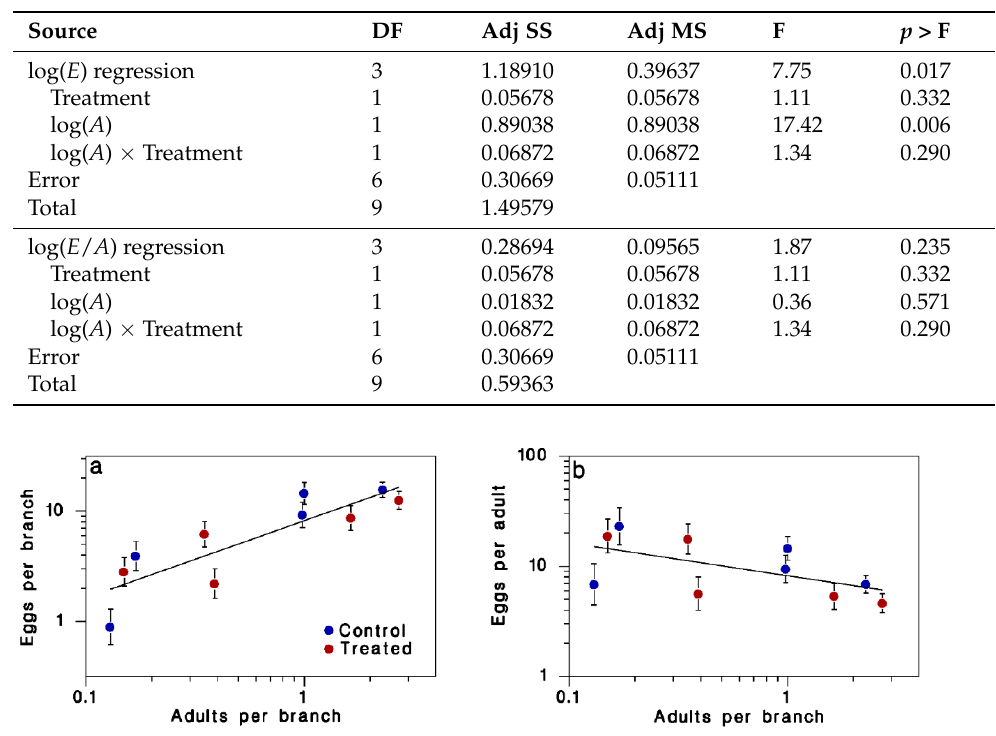
(Figure 6a; R 2 = 0.74; F = 21.29, df = 1,8, p = 0.002; test of residual normality: AD = 0.313, n = 10, p = 0.49). Figure 5. Mean (±SEM) adult SBW catch in pheromone traps. ( a ) In treated and ( b ) untreated blocks between June 30 and August 19, 2021. Block numbers in top right corners of panels. ( c ) Trap catch Table 3. Analysis of variance of the effect of log pupal case density log( A ) and treatment on log egg density log( E ) and log apparent fecundity log( E / A ).